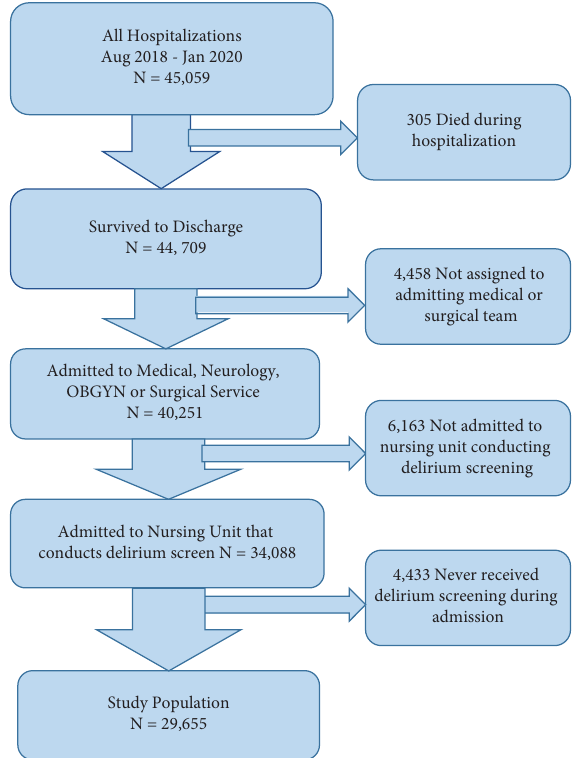
Figure 1: Consort diagram: study population and